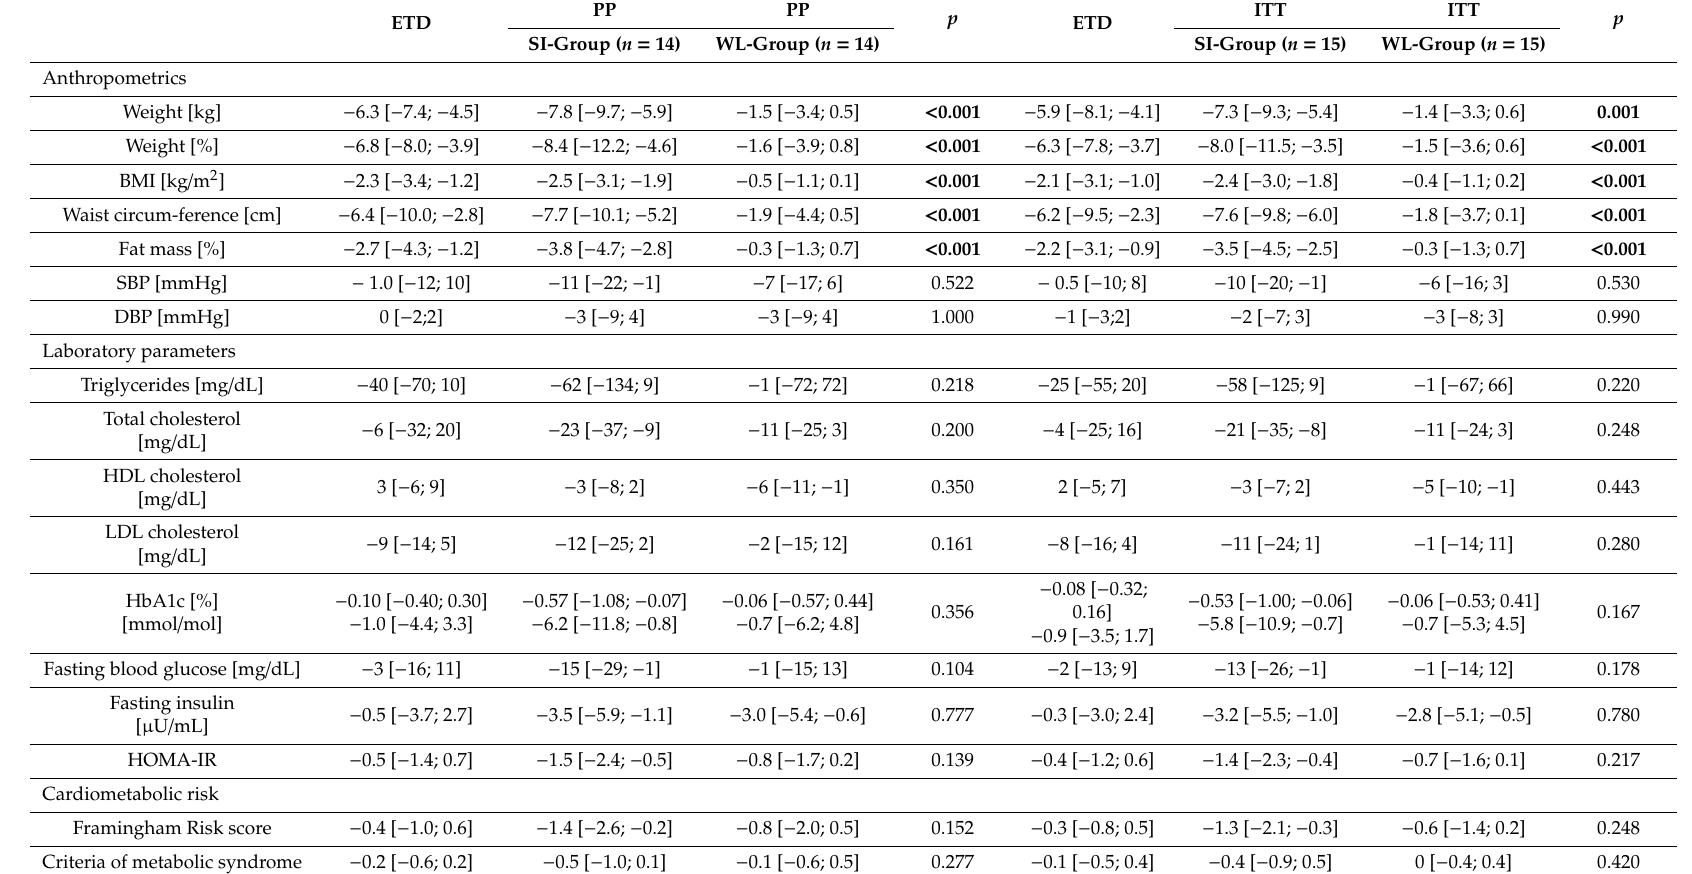
Table 2. Di ff erences after 12 weeks of